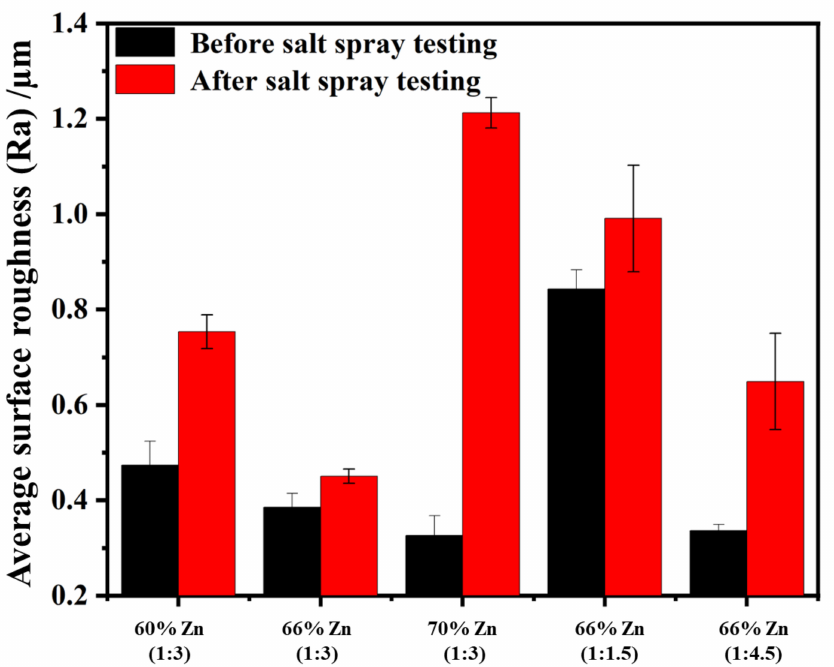
Figure 8. The line roughness of ZRP coatings with different content of zinc dust and replacing ratios of PPy/SCP particles before and after 500 h salt spray test.